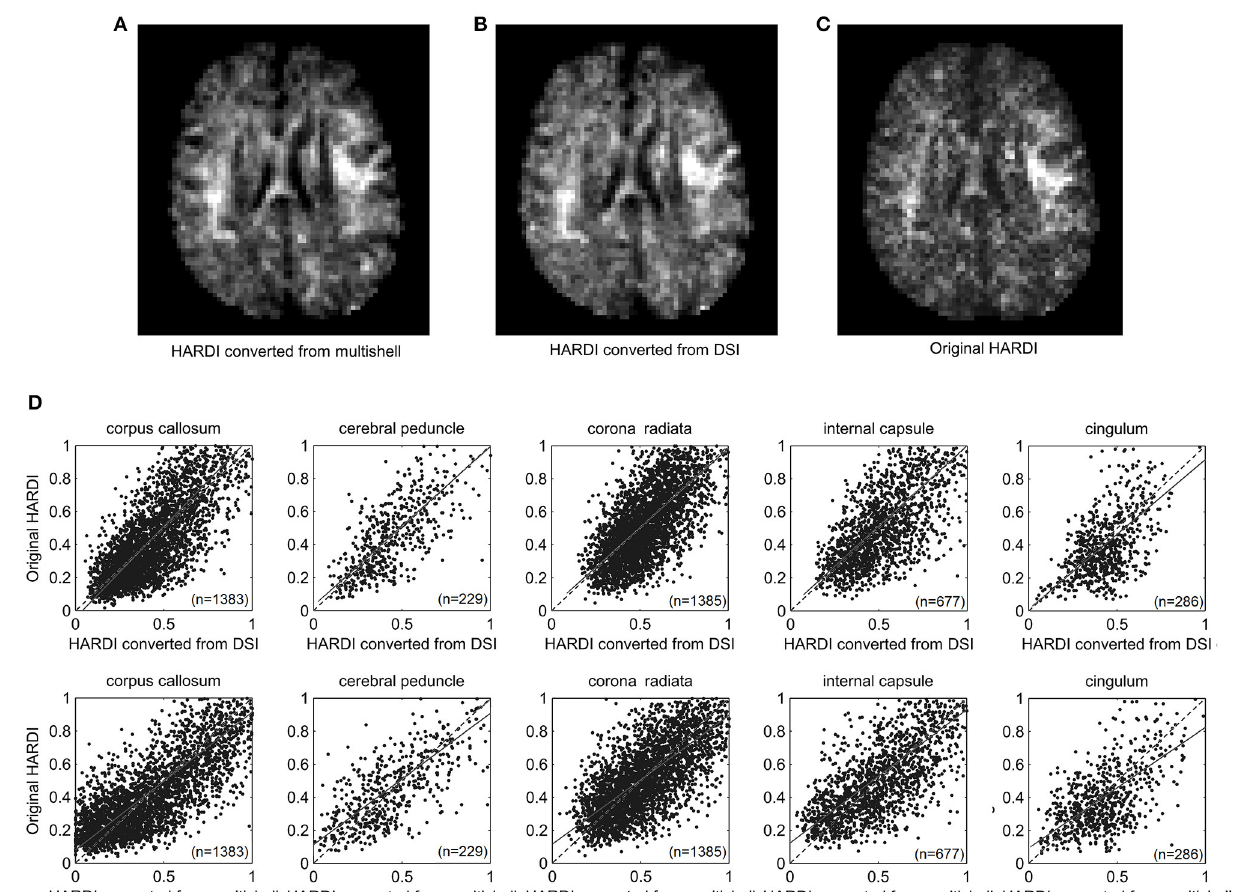
FIGURE 3 | The HARDI images converted from (A) a multi-shell scheme and (B) a DSI scheme compared with (C) the original HARDI images from the scanner. The converted HARDI images show a signal pattern similar to the original HARDI acquired from the MRI scanner. (D) The scatter plots show the signal correlation between the converted HARDI and the original HARDI in our in vivo study. The converted HARDI data correlates well with the original HARDI images ( r > 0.6).